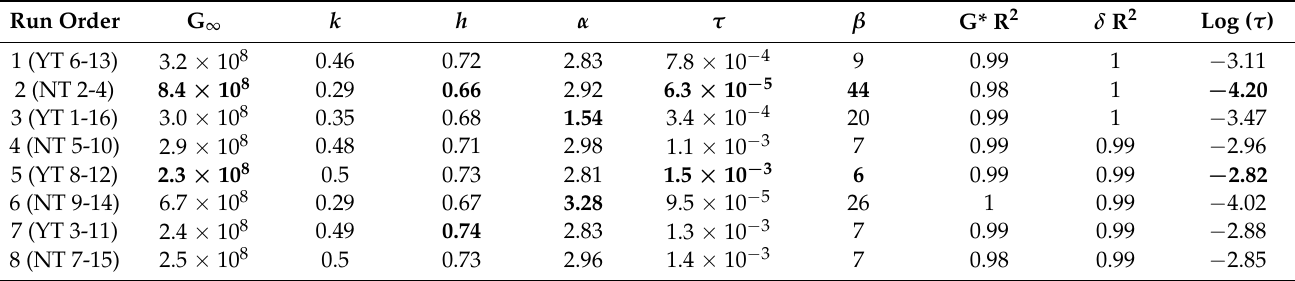
Table 11. The 2S2P1D model parameters for all runs for 70/100. Statistically significant differences between runs are denoted in